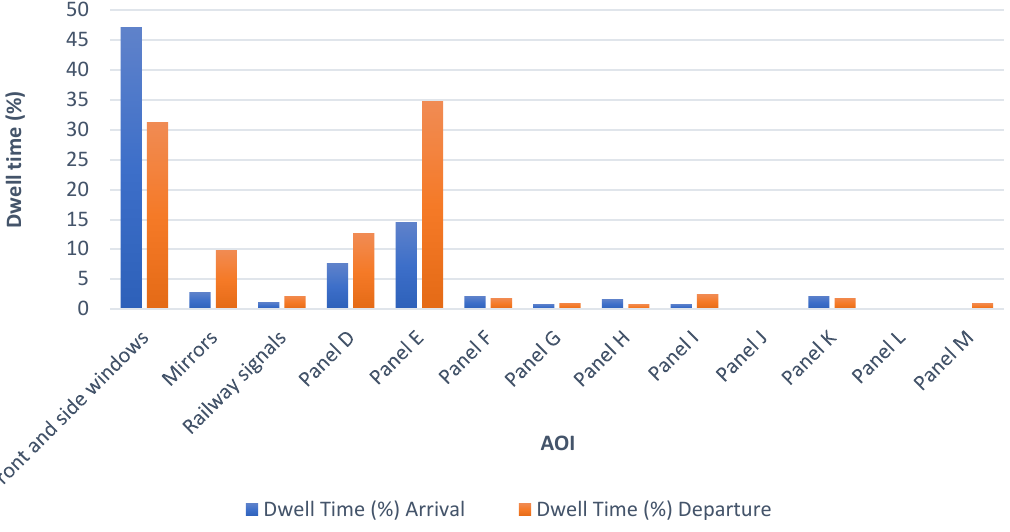
Figure 8. The comparison of the average dwell time between arrival and departure